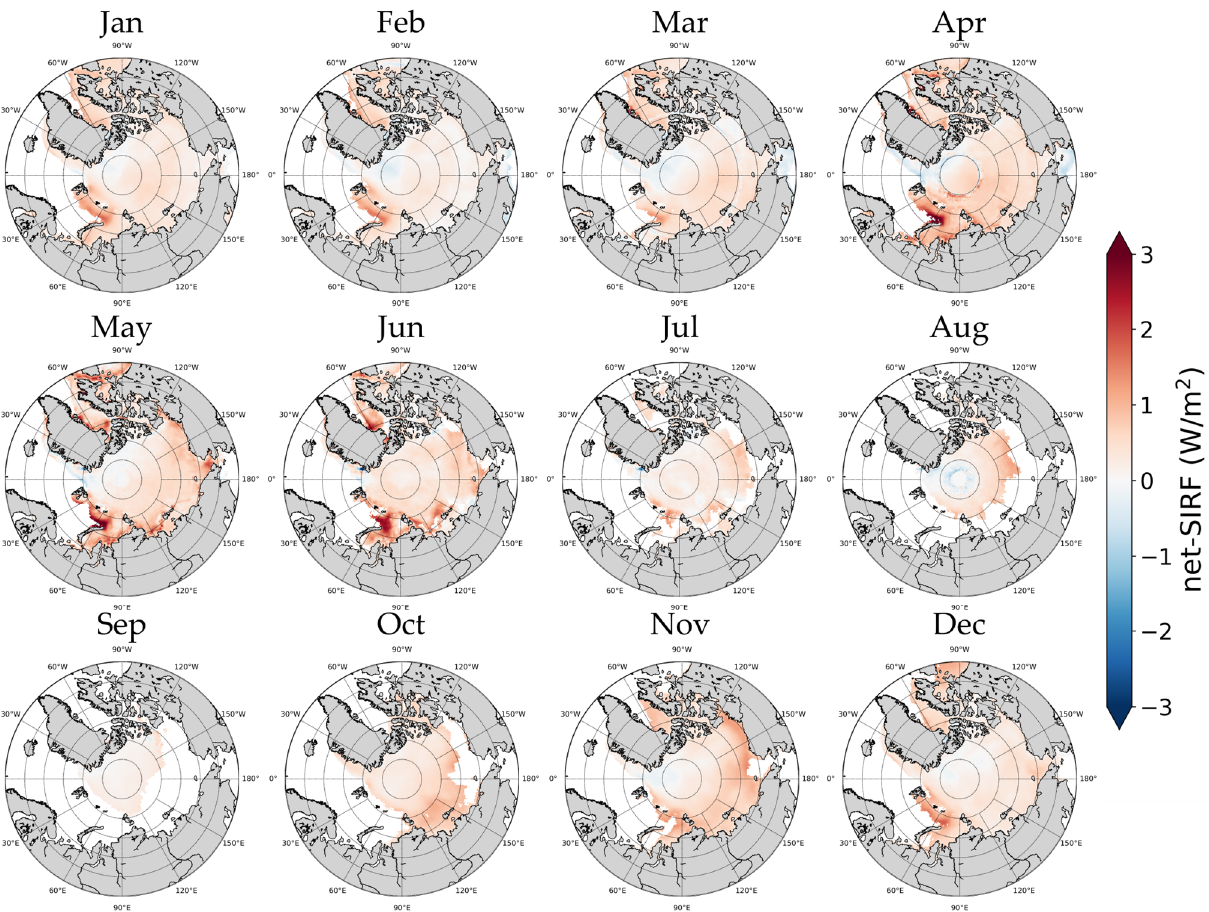
Figure 9. Spatial distribution of the net-SIRF monthly change.